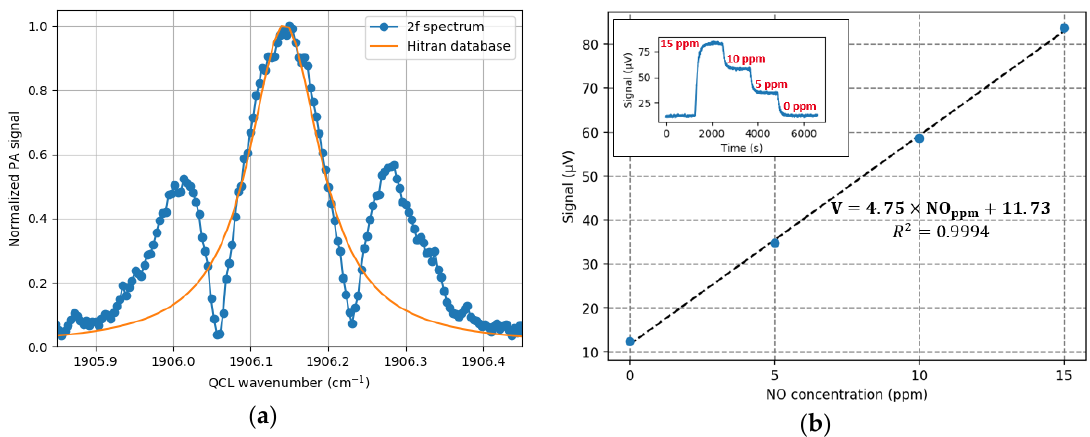
Figure 15. ( a ) 2f scan of the NO absorption line (blue) compared with the Hitran database (orange); ( b ) Calibration of the PA sensor for a measurement of 6600 s.